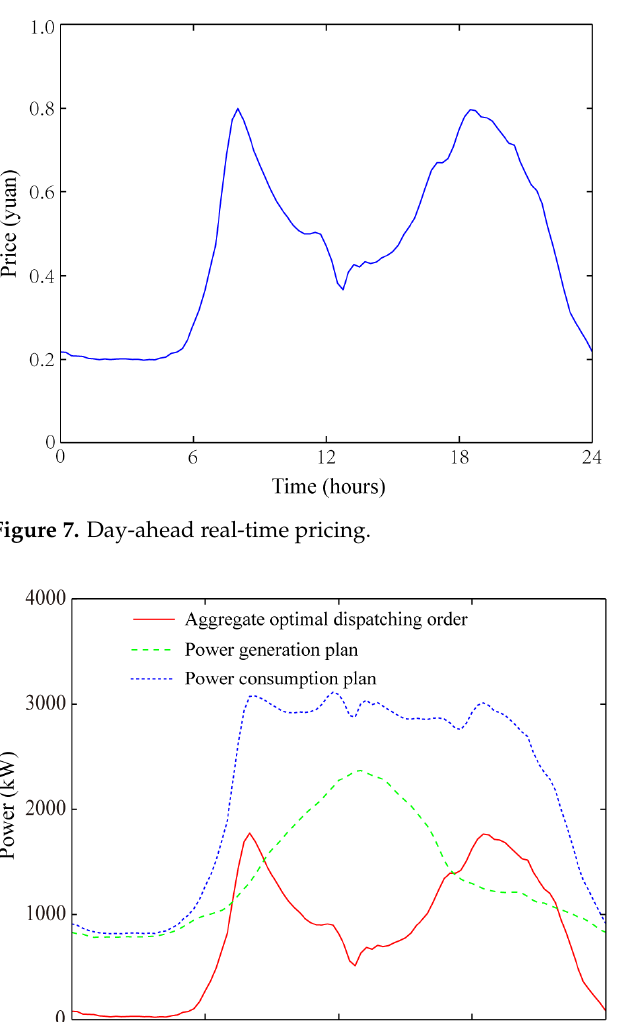
Figure 6. IEEE 33 bus distribution system.